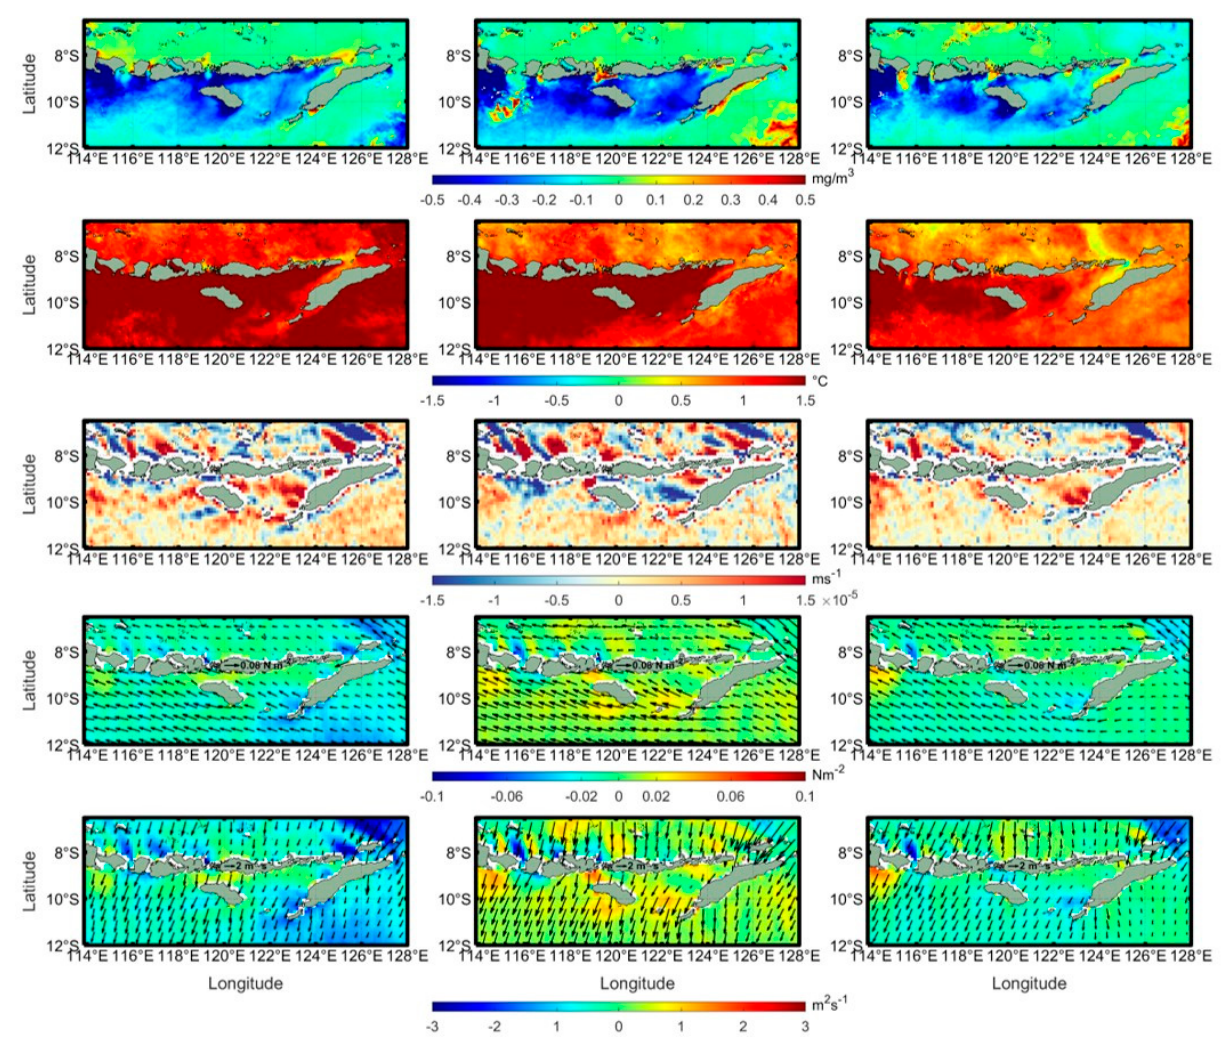
Figure 16. The anomalies of chlorophyll-a, sea surface temperature (SST), Ekman Pumping Velocity (EPV), wind stress, and Ekman Mass Transport (EMT) during the 2016 negative Indian Ocean Dipole (IOD) (June–August from left to right), respectively (from top to bottom).